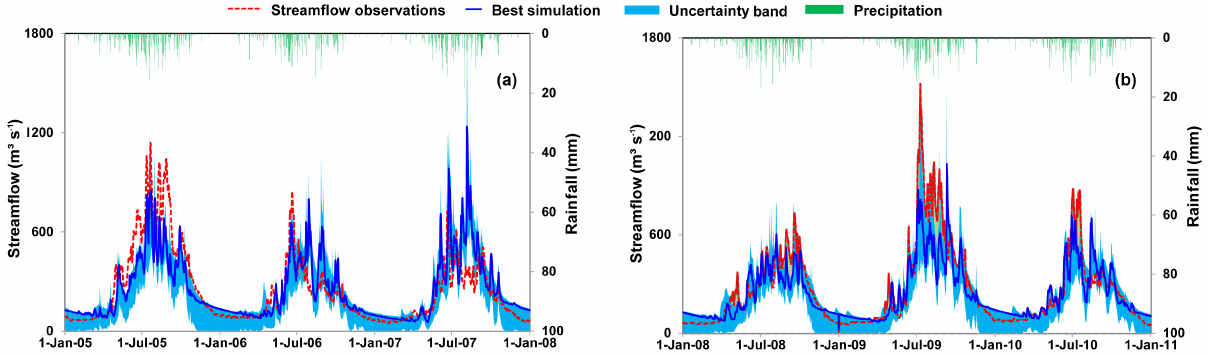
Figure 5. Simulated streamflow for the benchmark calibration of the Yalongjiang Basin in both the calibration (2005–2007) and validation (2008–2010)